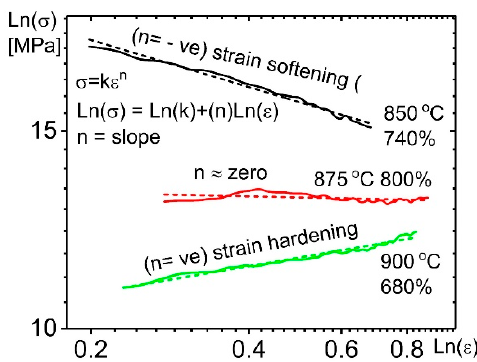
Figure 8. The dependence of strain hardening/softening on stress and strain for Ti-3%Mo-1%V-4%Al at 2 × 10 − 4 s − 1 and different temperatures.